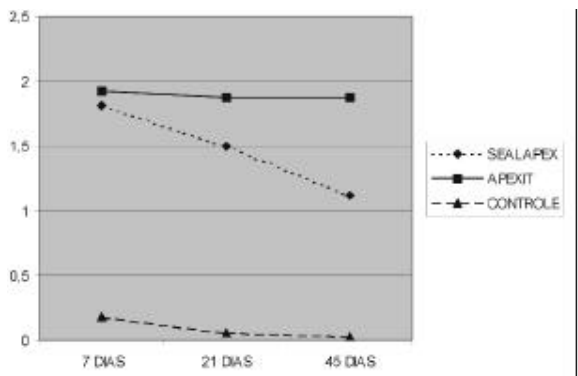
FIGURA 9 - Inter-relação dos índices gerais de inflamação dos cimentos Sealapex, Apexit e Grupo Controle